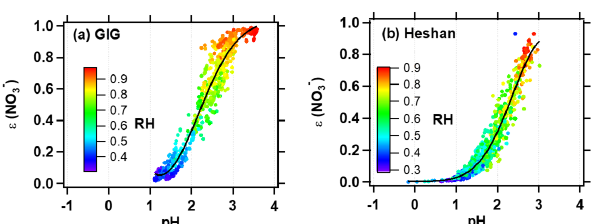
Figure 6. The particle fraction of nitrate in the sum of HNO 3 + nitrate ( ε (NO − ) against aerosol pH. The pH data are col- 3 ored by relative humidity and fit to an “s curve” in black line, as shown in Guo et al. (2018).